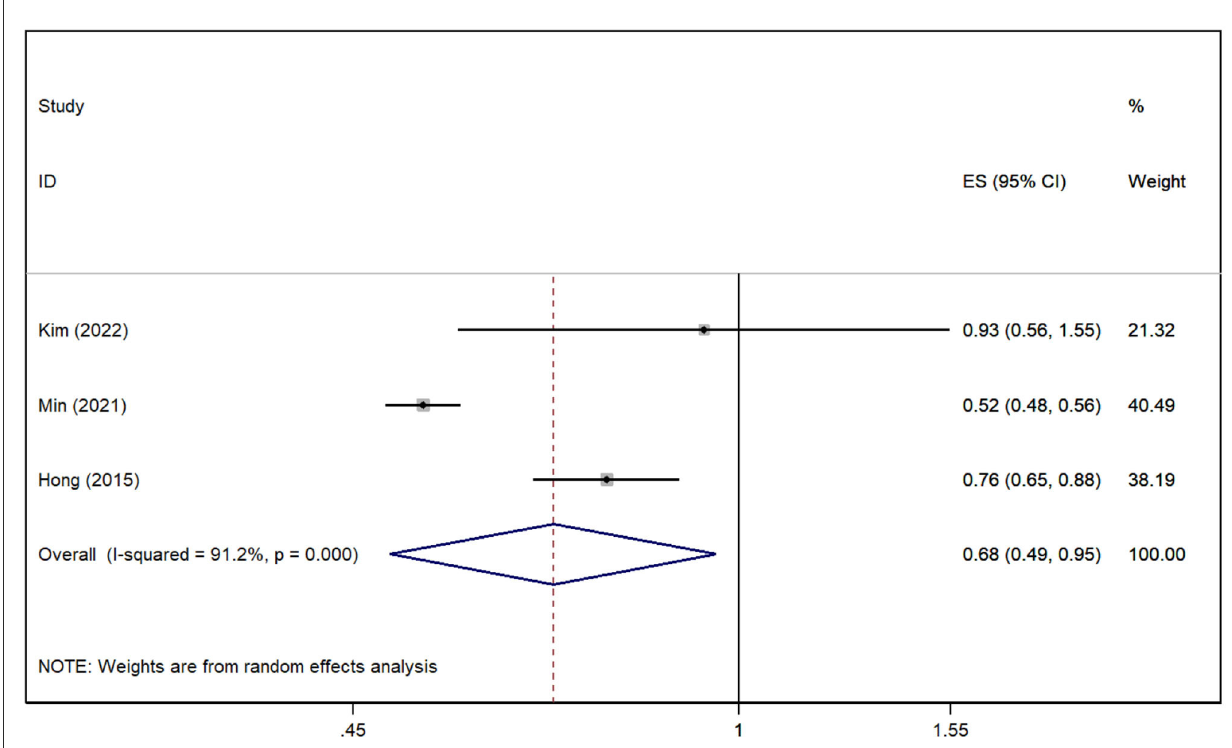
FIGURE4 Forest plot for the risk of VD in gout patients. ES, effect size.